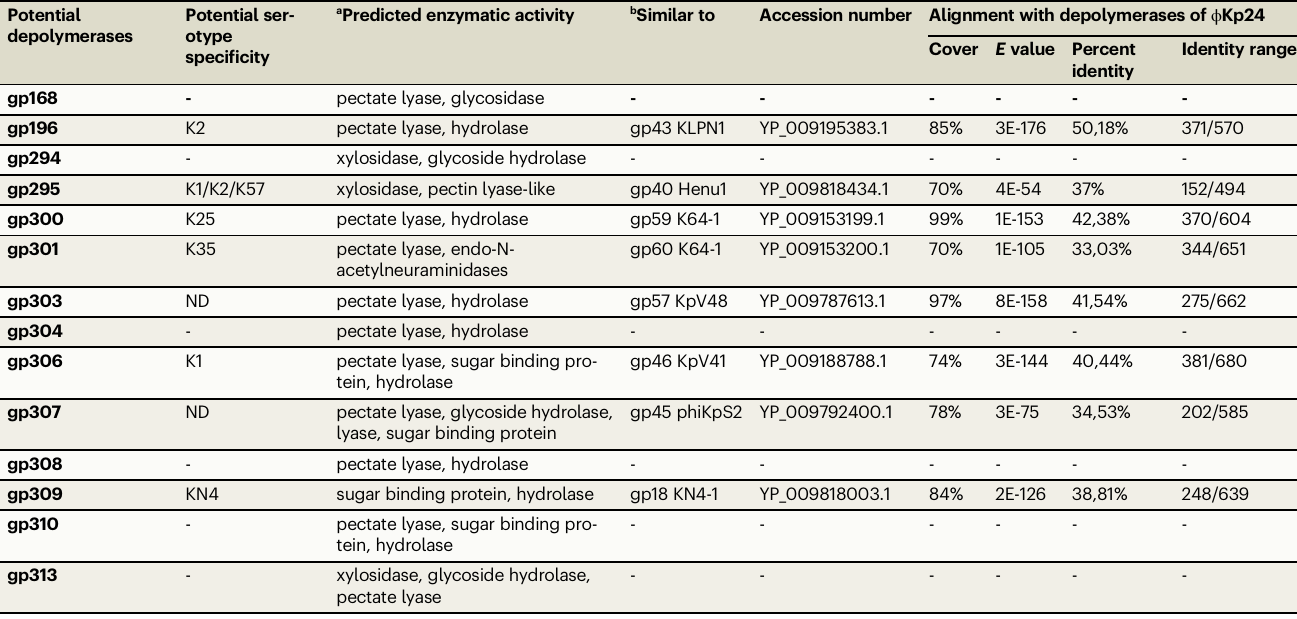
Table. 1 | Predicted K-serotype speci fi city and enzymatic activity of putative depolymerases of phage Φ Kp24 Potential